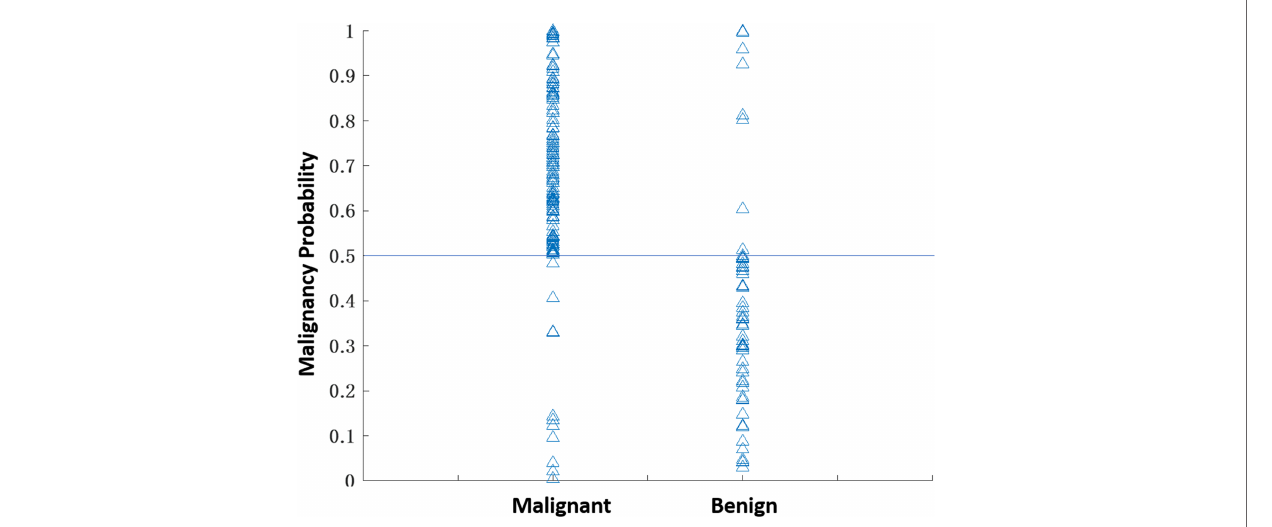
FIGURE 6 | The malignant probability predicted by the combined MRI+Mammography radiomics model in 202 lesions, 146 malignant and 56 benign, in the training set. Using the threshold of 0.5 as the cut-off, there are 135 true positive, 11 false negative, 46 true negative, and 10 false positive cases, with an overall accuracy of 181/202 =